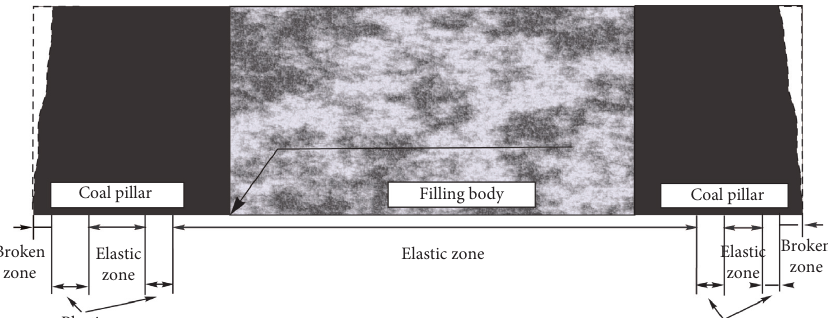
Figure 3: Diagram of Type I CSP.